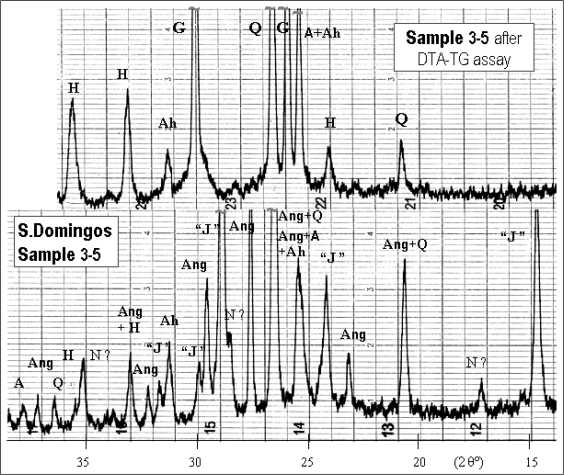
XRD spectra from São Domingos sample, as collected and after DTA-TG assay: Ang, H, “J”, and Q as quoted in Figure 2, plus A–anatase (TiO2, JCPDF card nr. 21-1272); Ah–anhydrite (CaSO4, 6-226); G–galena (PbS, 5-592); N?–natrojarosite, doubtful [NaFe3(SO4)2(OH)6, 11-302].